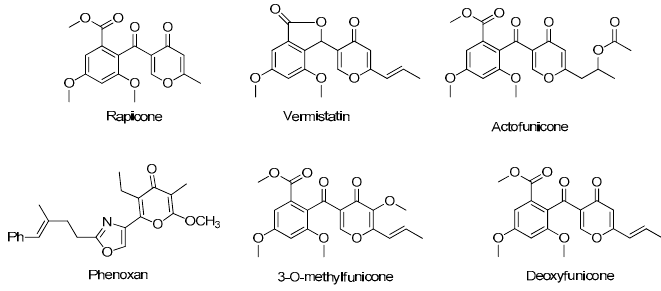
Figure 1. 4-Pyrones disclosed as biologically active organic molecules.